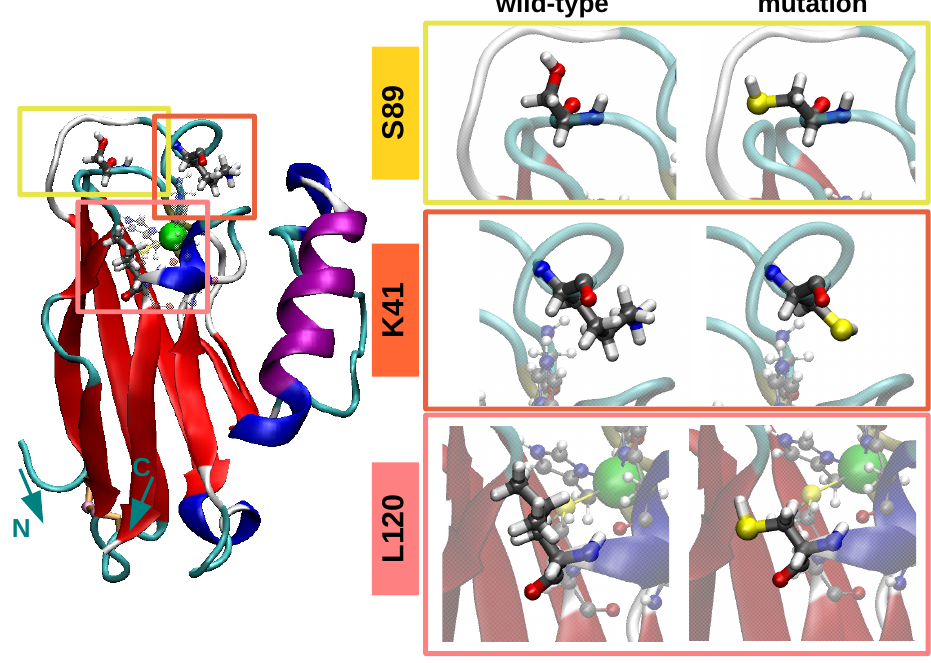
Figure 1. Initial configuration of the Azurin proteins. The Azurin is represented with its secondary structure: β -sheet (red), α -helix (purple), 310-helix (dark-blue), turns (cyan), and random-coils (white). The copper(II) ion is shown using its van-der-Waals representation in an opaque green color, and its coordination residues are represented with a ball-stick model. The disulfide bridge and the main chain of the two cysteines which formed it are colored in light orange. The sulfur atoms of these two cysteines are highlight in pink. The position of the three mutated residues (lysine 41, leucine 120 and serine 89) and the initial configuration (prior to minimization stages) of their side-chains in the wild-type and mutated proteins are here also indicated (orange, pink and yellow respectively). The distance between the Cu ion and the alpha carbon of the K41/L120/S89 mutated amino-acid is d Mut − Cu ∼ 9.1 Å/8.9 Å/11